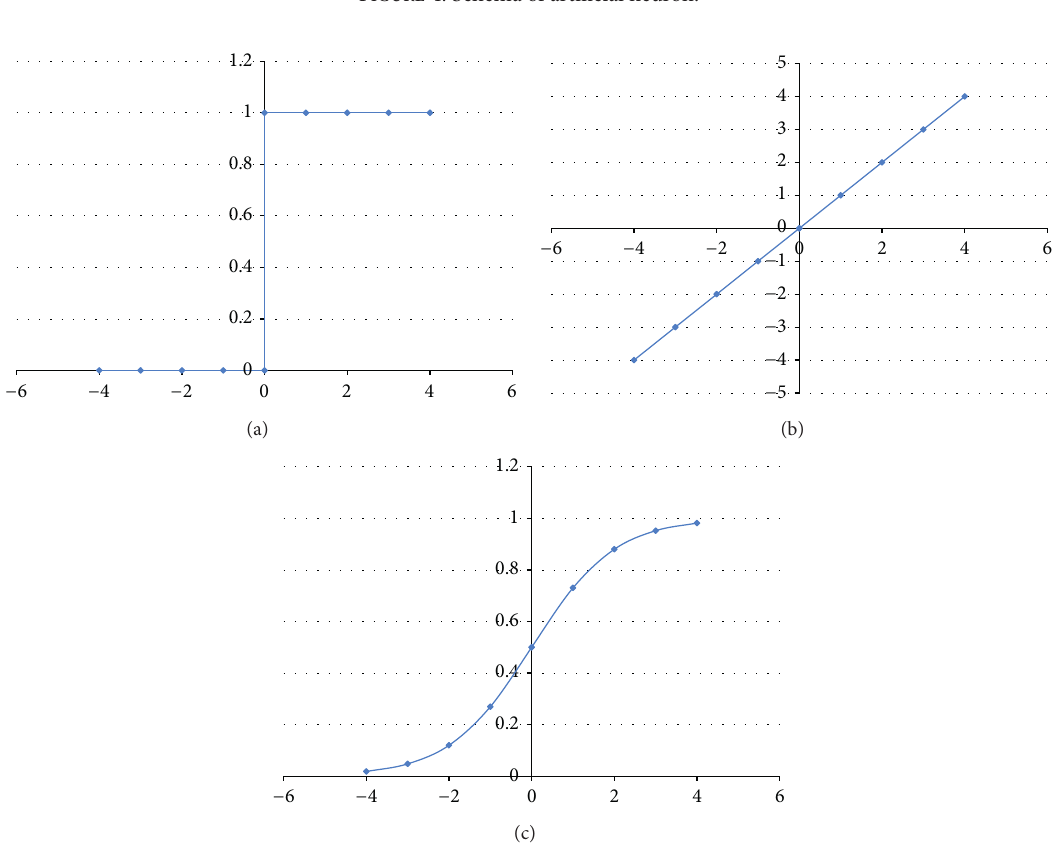
Figure 4: Schema of artificial neuron.